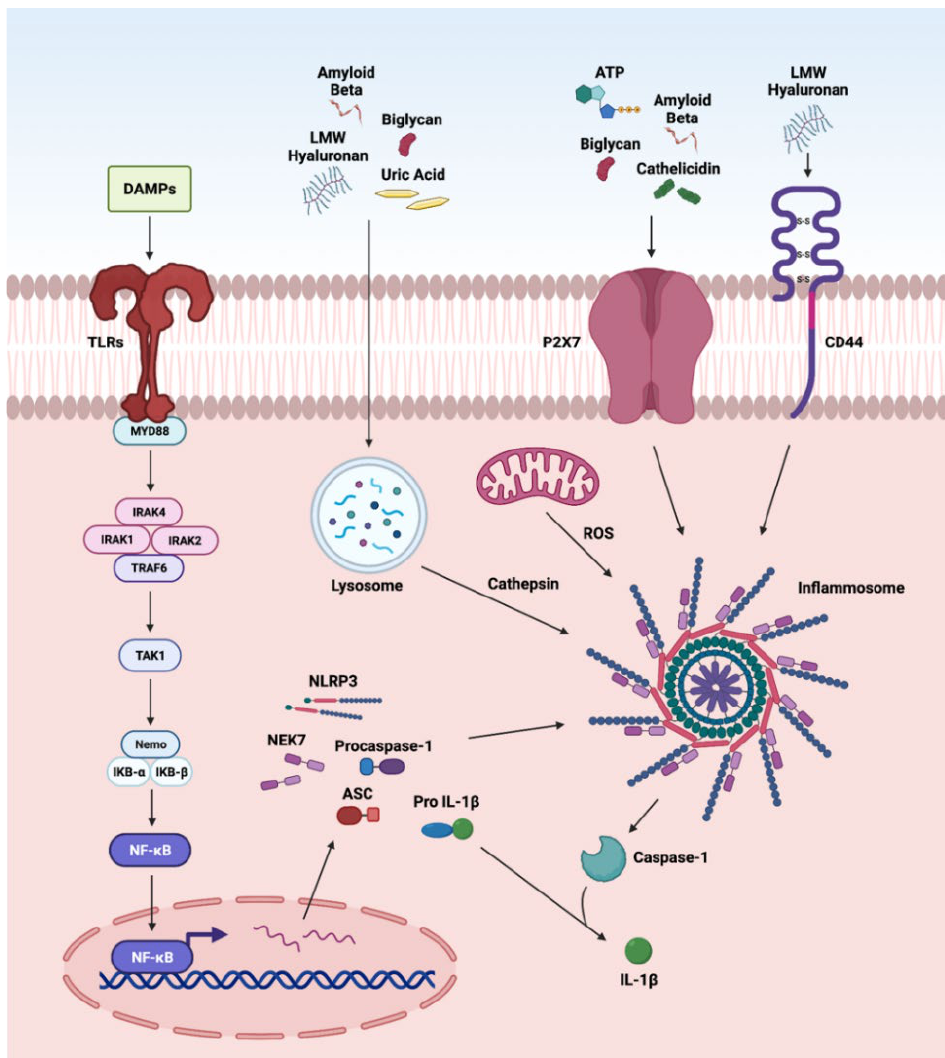
Figure 3. Overview of DAMPs activating the NLRP3 inflammasome. The first step in the 2-step process involves activation and translocation of NFκB into the nucleus to regulate the transcription of the oligomerization-like receptor pyrin-domain-containing protein 3 (NLRP3) inflammasome genes. The second step is actuation of NLRP3 inflammasome mediated by (a) DAMPs such as biglycan, LMW hyaluronan, uric acid, and Aβ to release cathepsin from lysosomal degradation; (b) K+ efflux via P2X7 receptor activation by DAMPs such as biglycan, ATP, A β , and cathelicidin; and (c) CD44 activation by LMW hyaluronan caspase-1 signaling pathway leading to caspase-1 activity and the release of mature IL-1 β